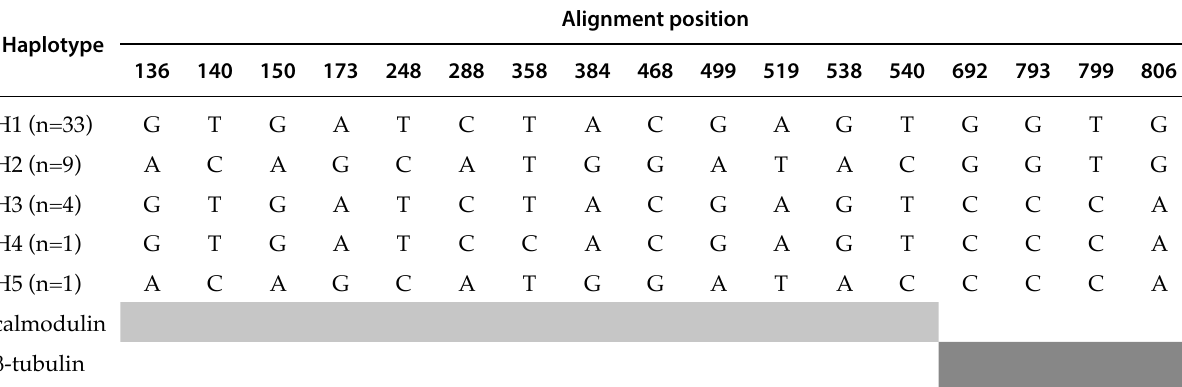
Table 4. Position of SNP’s differentiating haplotypes in the combined alignment of calmodulin and β-tubulin sequences. Capital letters indicate nucleotides present at the variable position for each haplotype. Positions 136 to 540 are part of the calmodulin sequence and positions 692 to 806 are part of the β-tubulin sequence. The combined alignment is 919 bp. The number of isolates for each haplotype is indicated in parenthesis. To construct the table, a total of 48 isolates was used (five isolates from each sampling site and three reference